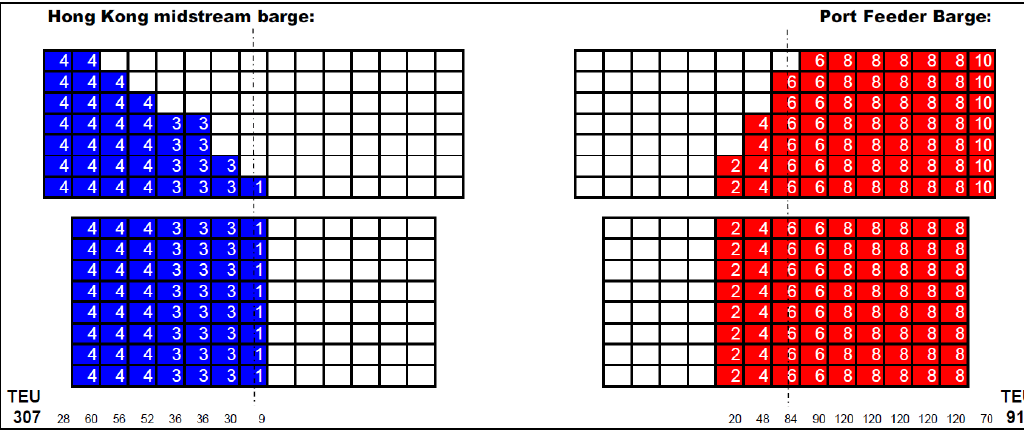
Figure 9: Hong Kong midstream barge vs. Port Feeder Barge - Total Slot Accessibility (serving a 6,000 TEU vessel)